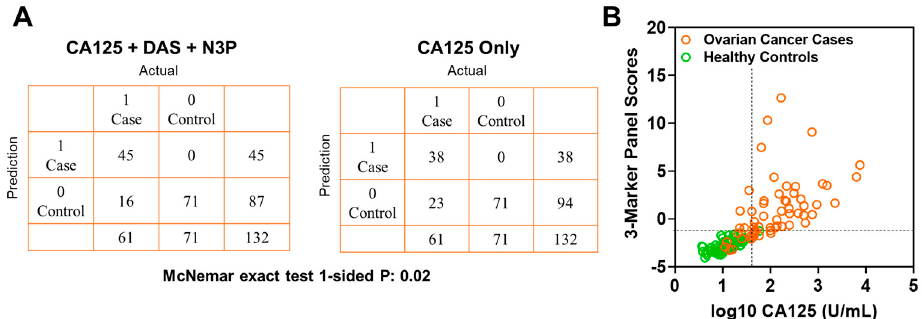
Figure 4. Classification performance of the 3 ‐ marker panel and CA125 in the validation set. ( A ) Confusion matrix describing the performance of the classification model corresponding to the 3 ‐ marker panel and CA125 alone at 99% specificity. Statistical significance was determined by 1 ‐ sided McNemar exact test. ( B ) Scatter plot illustrating the distribution of the 3 ‐ marker panel scores (Y ‐ axis) and log10 CA125 values (X ‐ axis). Broken lines represent > 99% specificity cutoffs.